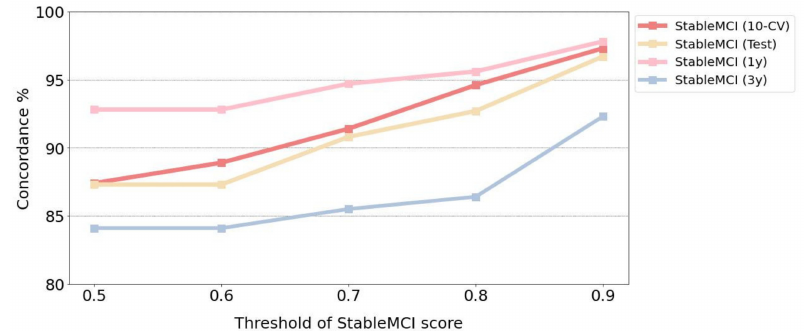
Figure 3. Concordance for various thresholds of the StableMCI